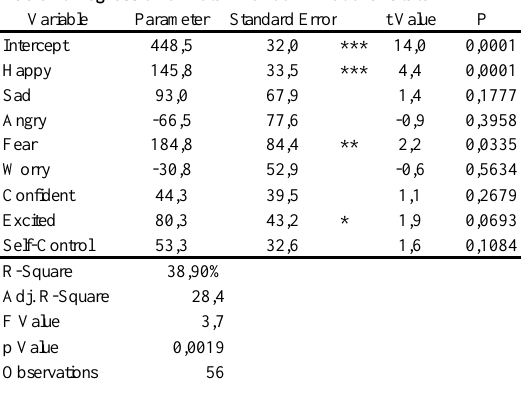
Table 4: Regression of Total Profit on Emotional State